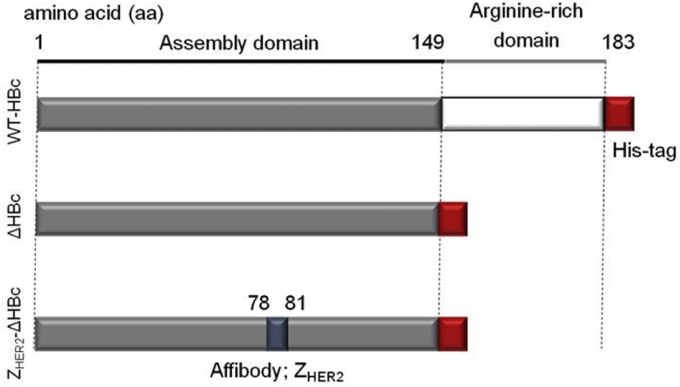
Amino acid sequence of the wild type (WT) and recombinant HBc particles used in this study. Wild-type HBc (WT-HBc) protein consists of an assembly domain (grey colour) and an arginine-rich domain (white colour). In the truncated HBc (ΔHBc) particles, the arginine-rich domain (150–183 aa) was deleted. In the HER2-targeting HBc (ZHER2-ΔHBc) particles, a ZHER2 affibody (blue colour) was inserted between 78 and 81 aa. For all constructs, His-tag (red colour) was fused to the C-termini to aid protein purification. (For interpretation of the references to colour in this figure legend, the reader is referred to the web version of this article.)